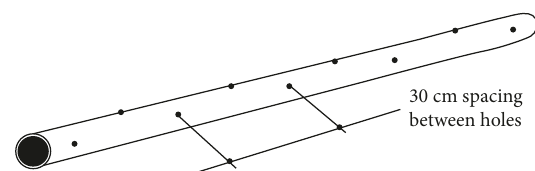
Figure 3: A sketch of the perforated pipes used for aerating the pipe